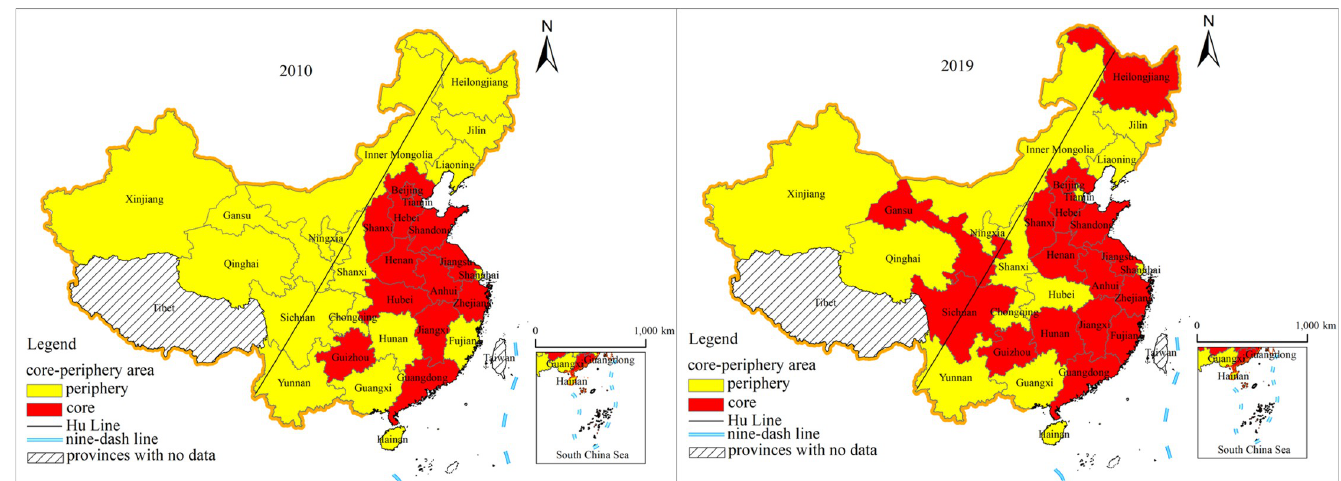
Fig 6. The “core-periphery” structure of China’s provincial tourism eco-efficiency in 2010 and 2019. (This map is based on the standard map with review number GS(2019)1697 downloaded from the Ministry of Natural Resources Standard Map Service website (http://bzdt.ch.mnr.gov.cn), and the base map has not been